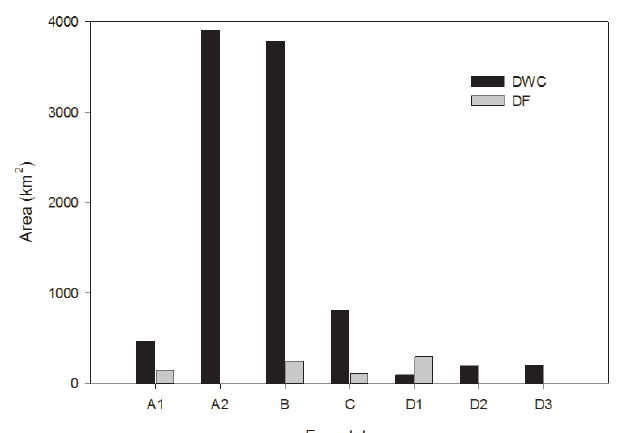
Figure 5: The total size of all protected areas distributed according to phyto-climatic zones and administering government